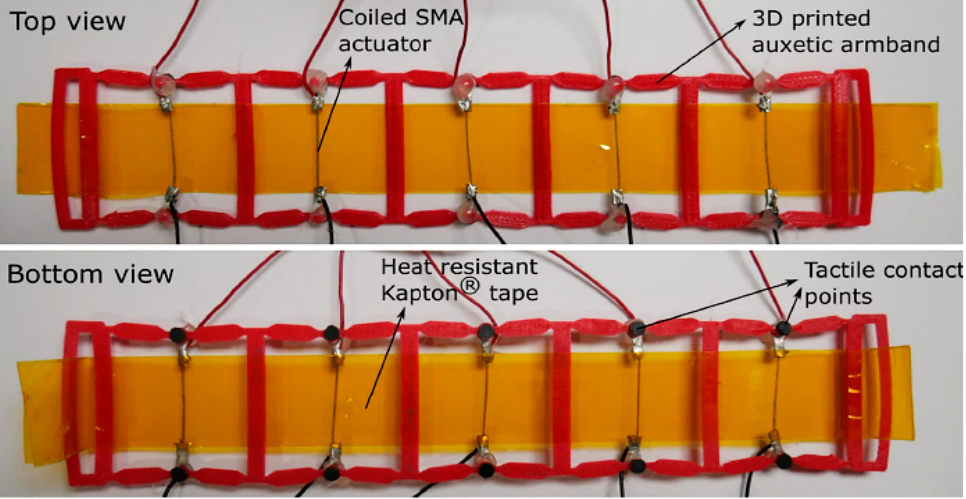
Figure 16. Haptic armband constituted of five re-entrant hexagonal components obtained by 3D printing. The device is actuated by twisted SMA wires, and the Kapton tape serves as a heat-resistant barrier [119].